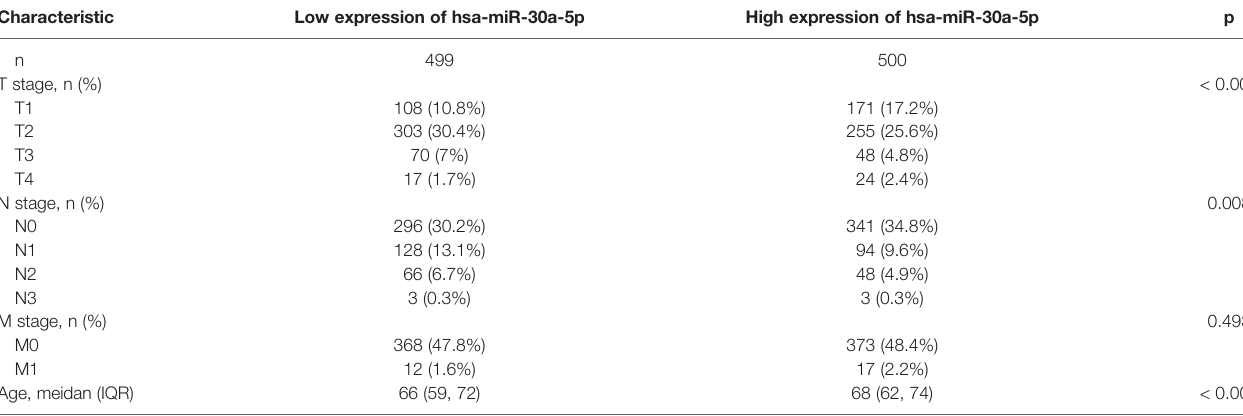
TABLE 1 | Analysis of the correlation between miR-30a-5p expression and clinic-pathologic features in the TCGA LUAD dataset. Characteristic